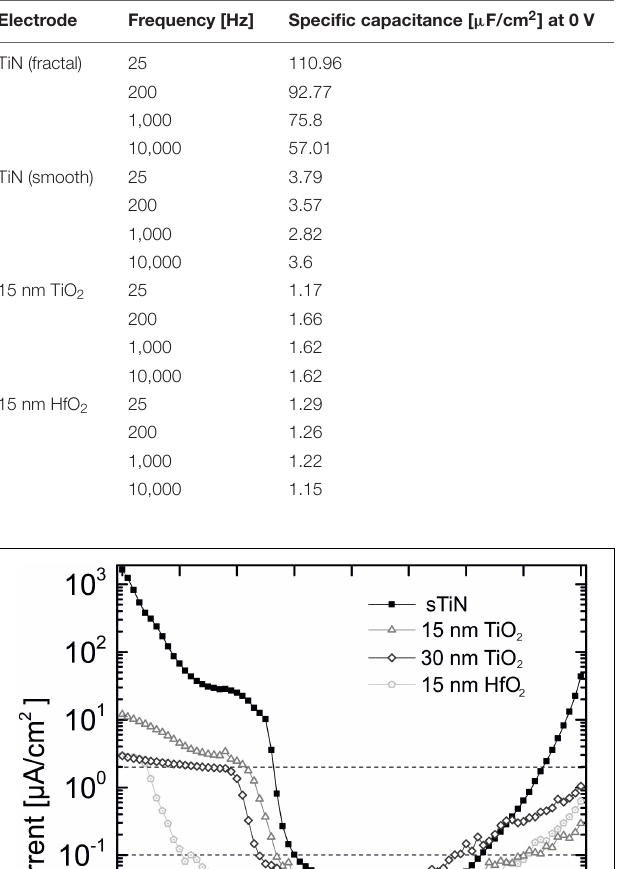
TABLE 1 | Specific capacitance at different frequencies (25 Hz, 200 Hz, 10 kHz, and 10 kHz) for 15 nm HfO 2 or TiO 2 on smooth TiN electrode (320 × 320 µ m 2 ) compared to the specific capacity of uncoated electrodes of both fractal and smooth TiN.